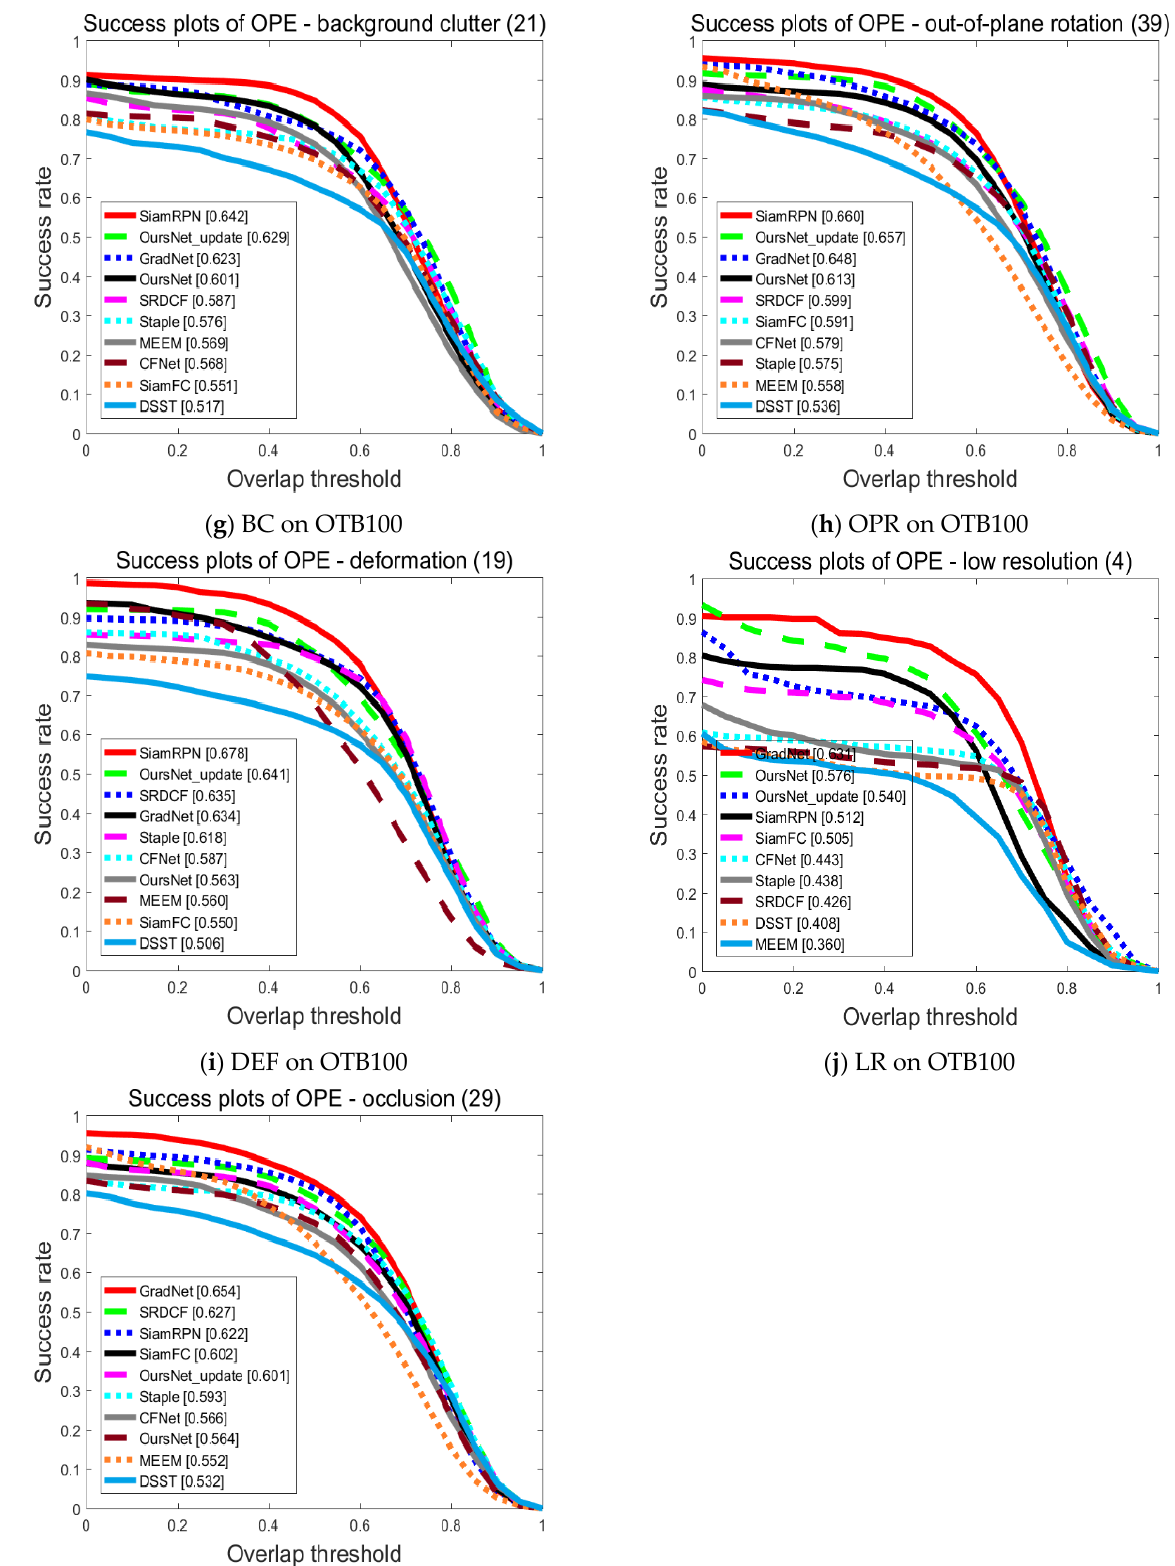
Figure 7. Performance evaluation results of different algorithms on OTB100 dataset for various attributes.